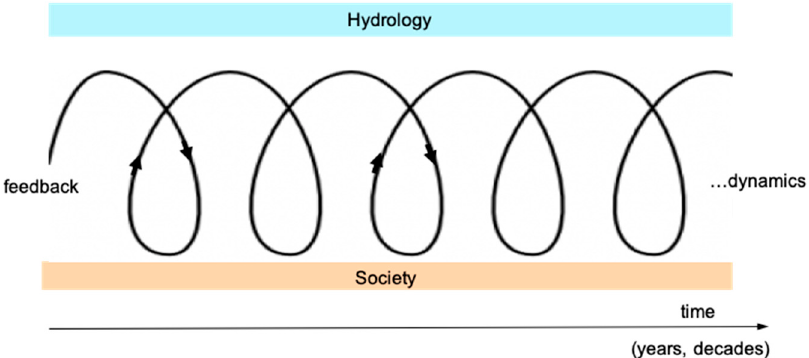
Figure 1. Authors’ interpretation of sociohydrology, adapted from Di Baldassare et al. [42]. The feedback loops represent the interplay between water and society. The relationship between water and society is external.